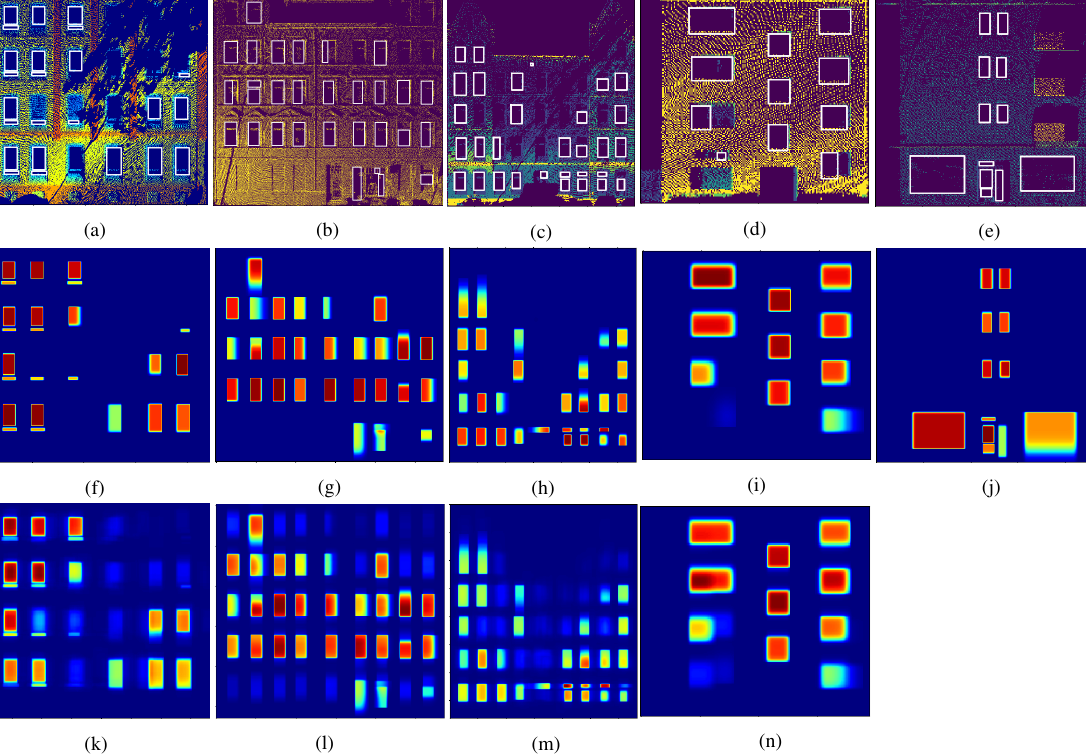
Figure 8. The uncertainty models and prior detected results of windows: (a), (b), (c), (d), (e) are the prior detected windows and the rectangles denote the prior shapes of the windows. (f), (g), (h), (i), (j) are the corresponding window uncertainty models, where warmer colors represent higher likelihood of being window areas. (k), (l), (m), (n) illustrate the inferred likelihood of occluded or non-measured windows; note that they are shown with different shades of